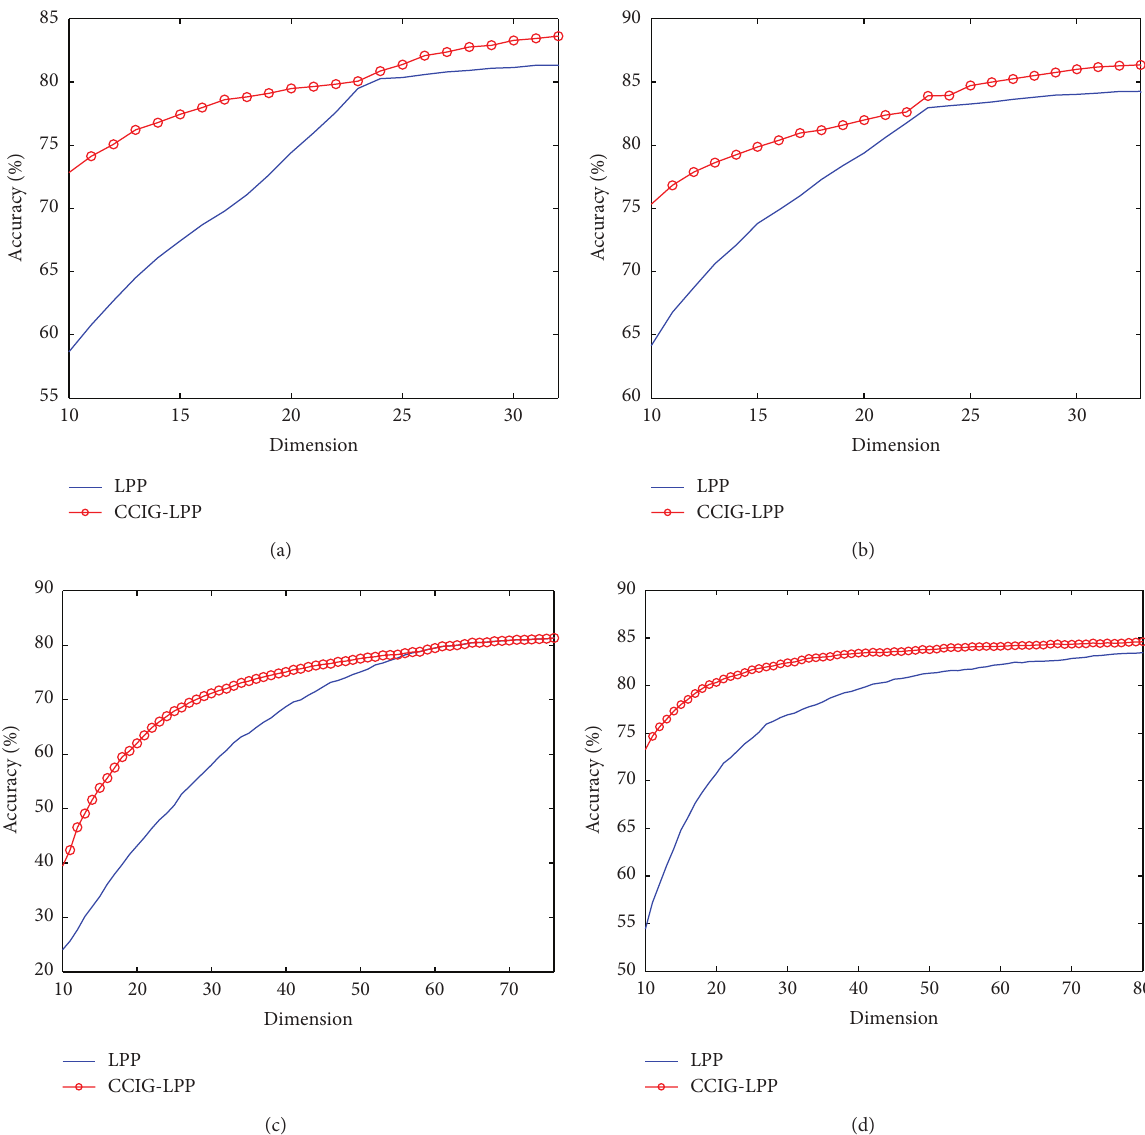
Figure 8: The recognition accuracies of LPP and CCIG-LPP versus the dimensions when three and four images were randomly selected for each category for training. In (a) and (c) three respective images of each category were randomly selected for training. In (b) and (d) four respective images of each category were randomly selected for training. In (a) and (b) SM-gist was used to extract gist features. In (c) and (d) we use Siagian and Itti’s feature extraction model to extract gist